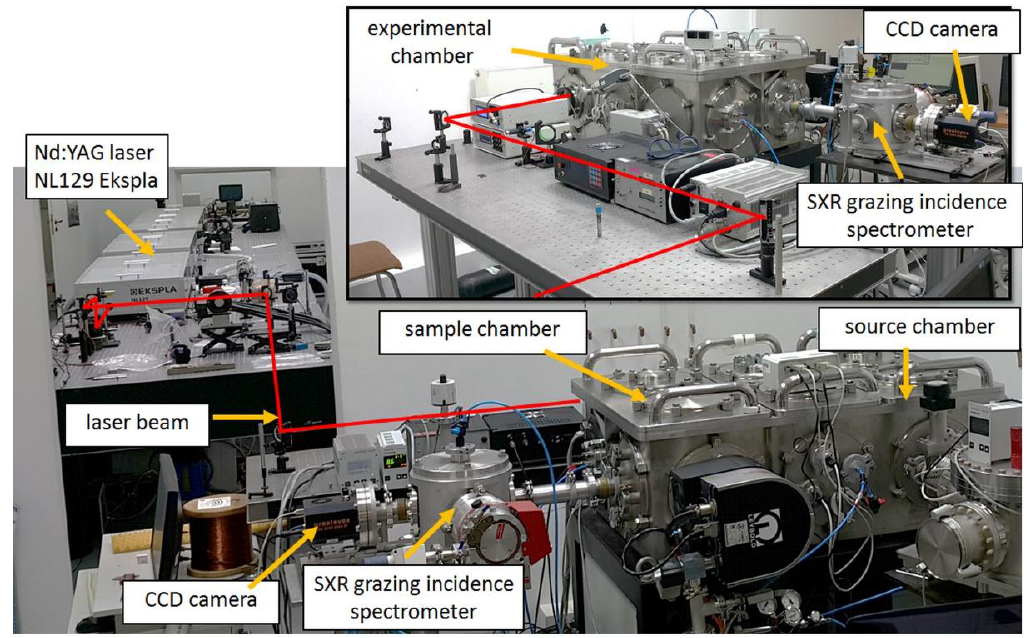
Figure 2. Photograph of the single SXR pulse NEXAFS system.